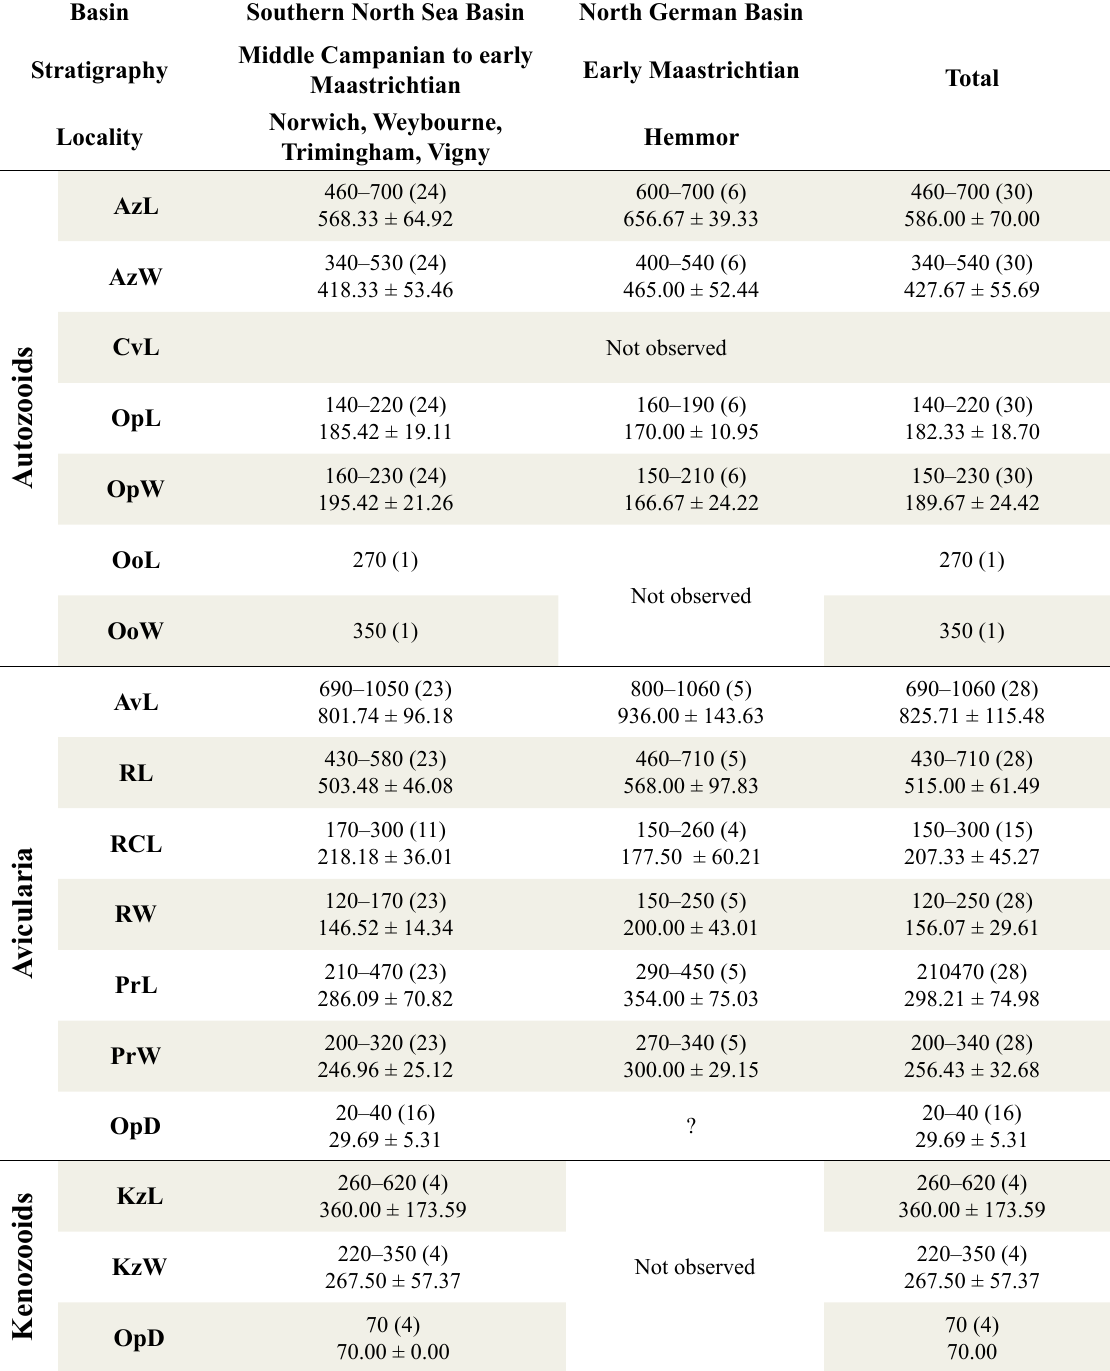
Table 4. Summary of measurements of Rhagasostoma angliae Brydone, 1936. For each parameter the range is given with the number of measurements in brackets. The arithmetic mean is given ± standard deviation. All measurements in